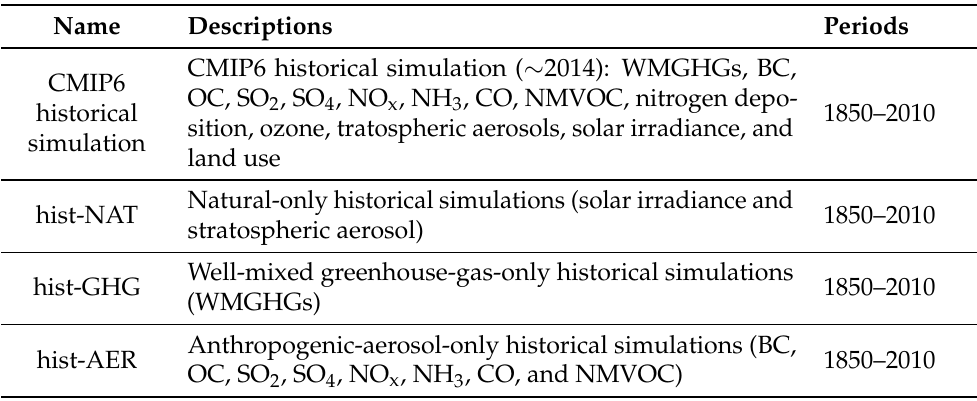
Table 1. List of DAMIP experiments analyzed in this study (from Gillett et al. [3]).